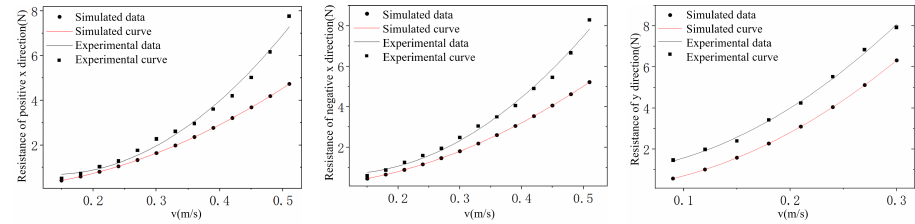
Figure 30. Comparison of hydrodynamic coefficients obtained by CFD method and physical experi- ment platform. From left to right: the comparison results in + x -direction, the comparison results in − x -direction, and the comparison results in y